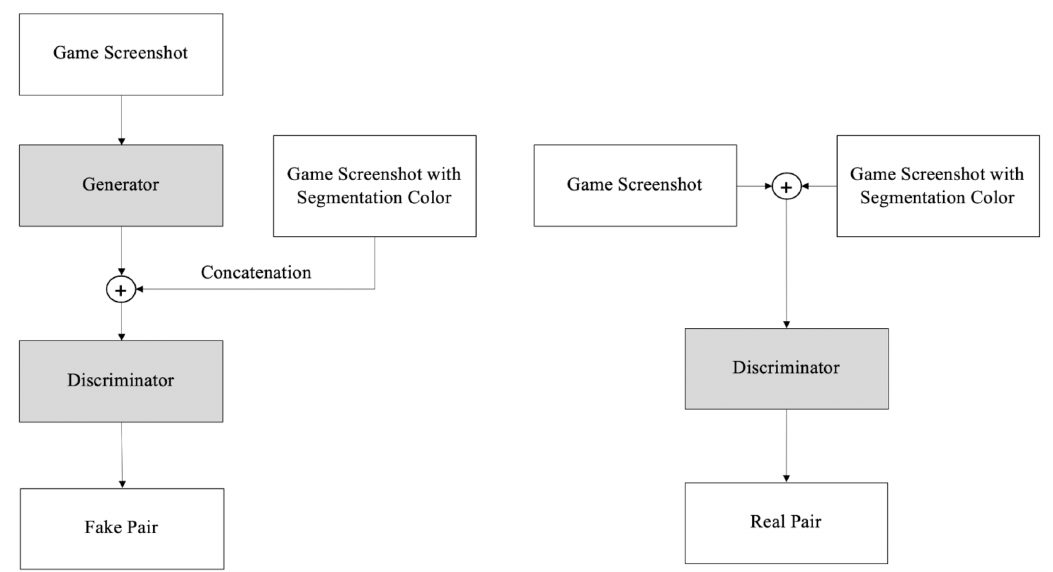
Figure 6. Proposed GAN